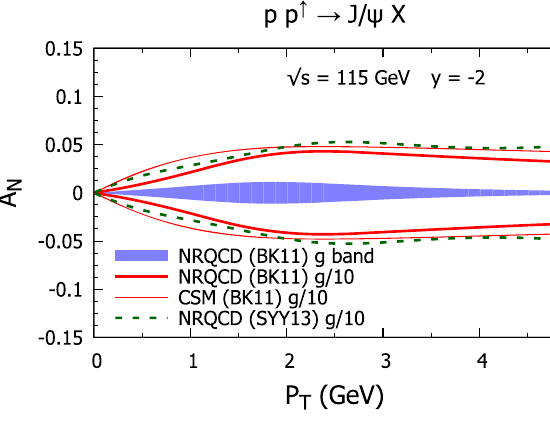
Fig. 6 Maximized values for A N for the process pp ↑ → J /ψ X at √ s = 115 GeV and P T = 2 GeV as a function of x F (left panel) and at y = − 2 as a function of P T (right panel), for the gluon Sivers effect only. Curves are obtained within the NRQCD approach, adopting the BK11(thickredsolidlines)andtheSYY13(greendashedlines)LDME